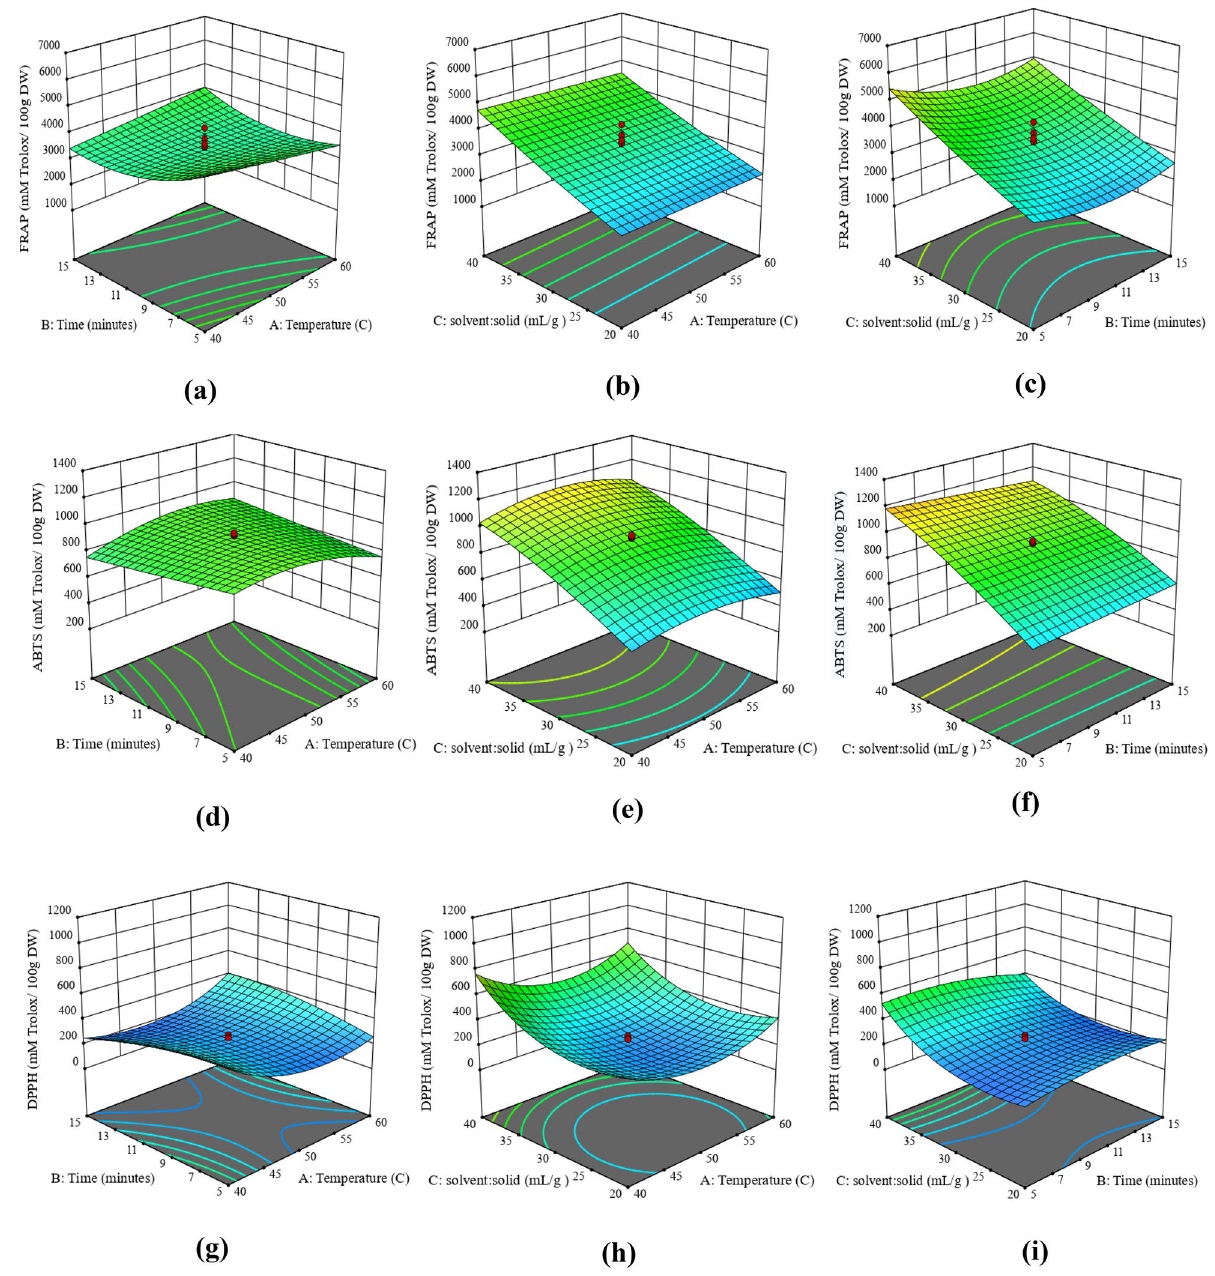
Figure 4. Response surface plots for representation of the combined effects of ( a ) A and B on FRAP, ( b ) A and C on FRAP ( c ) B and C on FRAP, ( d ) A and B on ABTS, ( e ) A and C on ABTS ( f ) B and C on ABTS, ( g ) A and B on DPPH, ( h ) A and C on DPPH ( i ) B and C on DPPH (A: Temperature (°C), B: Time (minutes), C: Solid to solvent ratio Hence the extraction conditions of microwave temperature of 40 °C, time of 5 min, and solid to solvent ratio (1:40) were the optimized results for the maximum DPPH value. Optimization of extraction factors and validation of the model. In study 3, the conditions for MAE of bioactive components from carrot rejects were optimized to maximize the yield of Total carotenoids, Total polyphenols, and Total antioxidants by FRAP, ABTS, and DPPH. For the optimization at a maximum yield of all the parameters Derringer’s desirability prediction method was used and the results were represented in Table 6. The optimized factors for the maximum yield of bioactive components were Temperature of 50 °C, time of 5 min, and Solid to the solvent ratio (1:40 w/v). For these optimized parameters the predicted values for TCC, TPC, and antioxidant activity by FRAP, ABTS, and DPPH were determined by Design-Expert software and presented in Table 6. Further, these predicted values were compared with the experimentally determined values